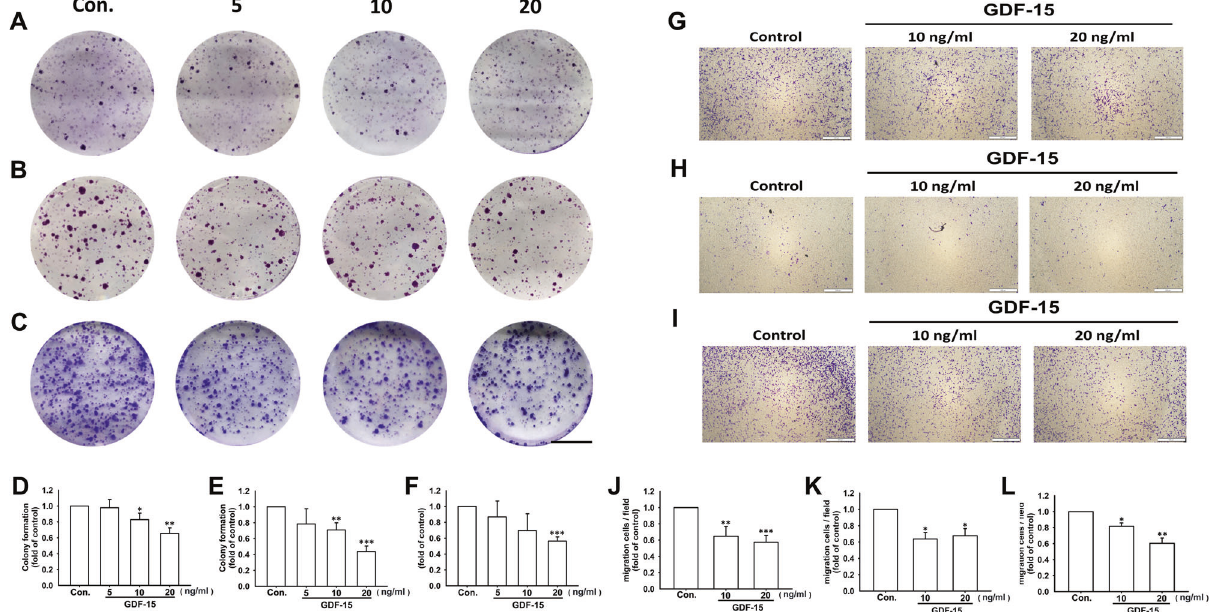
Fig. 6 Colony formation and cell migration are inhibited by recombinant GDF-15 in breast cancer cell lines. Both JC and 4T1 cells were treated with murine recombinant GDF-15 protein (5 – 20 ng/ml), and MDA-MB-231 cells were treated with human recombinant GDF-15 protein (5 – 20 ng/ml). After GDF-15 treatment for 10 days, the number of colonies formed (bigger than 1 mm in diameter) were counted. Note that colony formation of JC ( A , D ), 4T1 ( B , E ), and MDA-MB-231 cells ( C , F ) were all inhibited by GDF-15. Scale bar, 1 cm. In cell culture insert system, GDF-15 treatment for 24 h also reduced cell migration in JC ( G , J ), 4T1 ( H , K ), and MDA-MB-231 cells ( I , L ). Scale bar, 400 μ m. Graphs showed mean ± S.D. of three independent experiments. p value was calculated using Student ’ s t test. * p < 0.05; ** p < 0.01; *** p < 0.001 compared to control